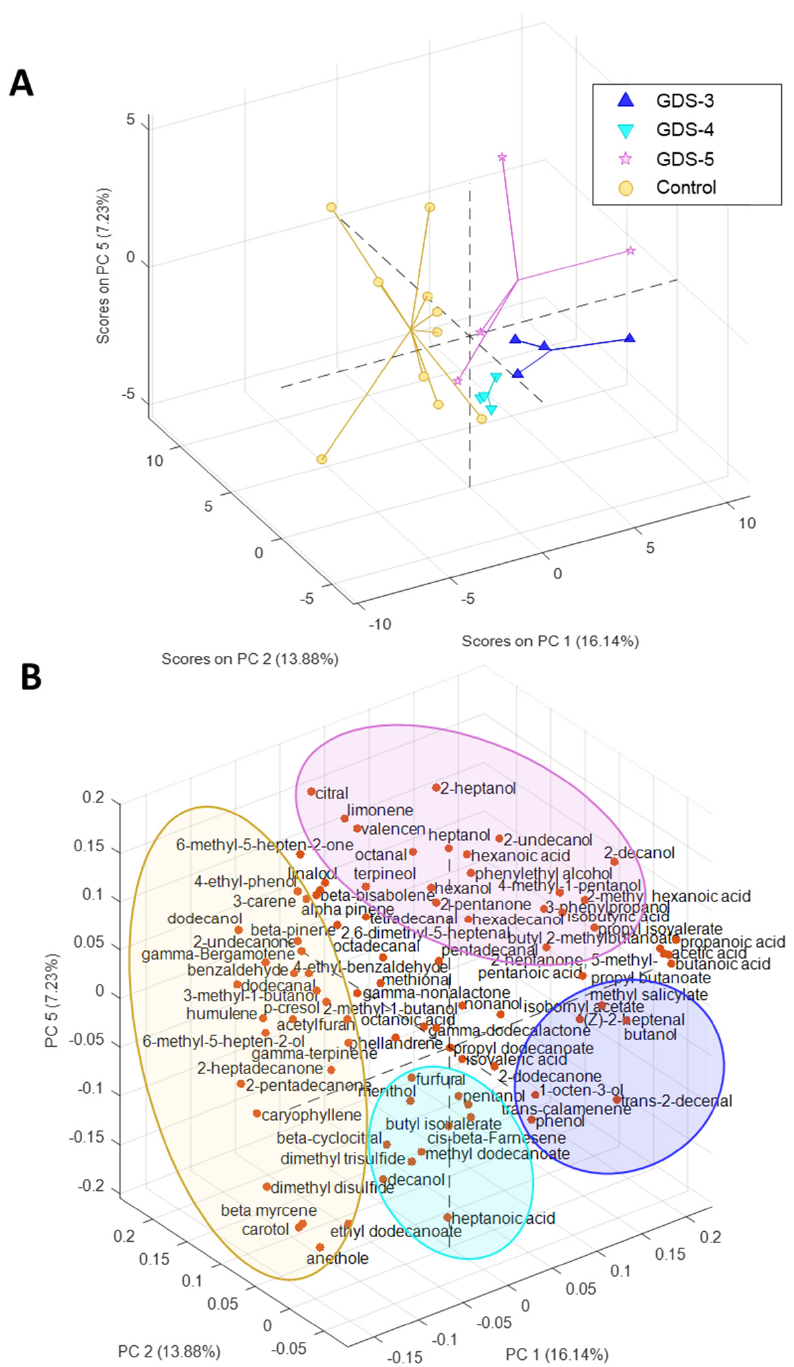
Figure 2. Principal component analysis (PCA) of the fecal volatile organic compounds (VOCs) in Alzheimer’s disease (AD) and the control subjects. The ( A ) scores and ( B ) loadings plots of the PCA model carried out with the relative peak area of the total VOCs obtained from the control subjects and the AD patients classified in the stages: GDS-3, GDS-4 and GDS-5; (n = 10, control subjects; n = 12, AD patients; 4 per stage).